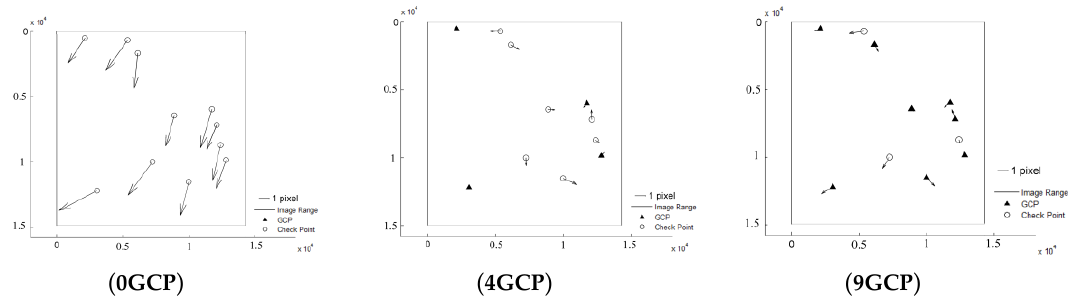
Figure 6. Residual distributions of check points of orientation for ALOS.